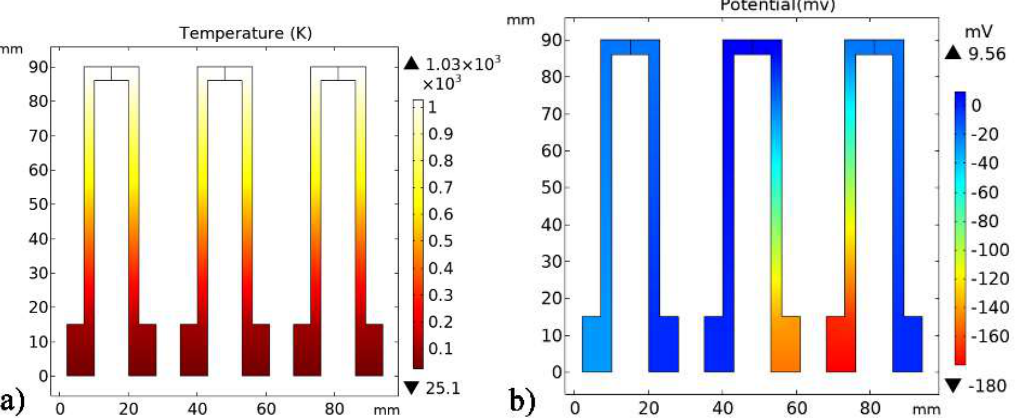
Figure 2. Simulation of three combinations. ( a ) The temperature difference distribution of thermocouples. ( b ) The thermoelectric voltage distribution.